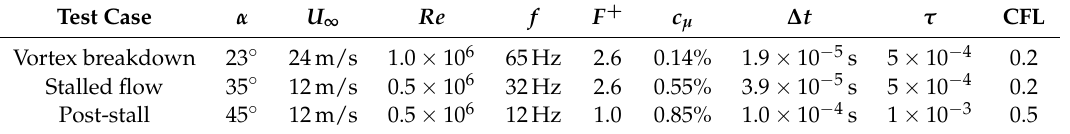
Table 1. Test cases with corresponding control and numerical